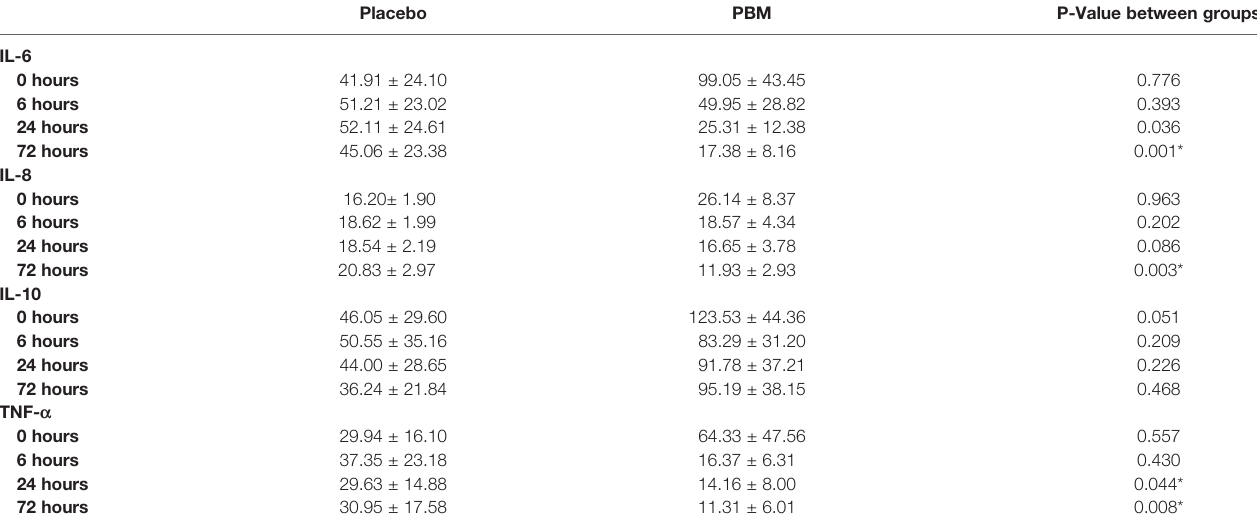
TABLE 2 | Raw values (mean +/- SEM) for IL-6, IL-8, IL-10, and TNF- a secretion levels at T=0, 6, 24, and 72 h, of PBM and Placebo groups.